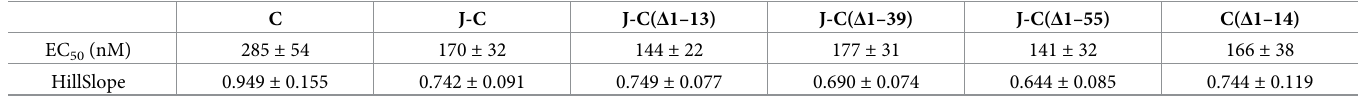
Table 3. EC 50 and Hill coefficient of RII β 2 C 2 , RII β 2 J-C 2 RII β 2 J-C( Δ 1–13) 2 , RII β 2 J-C( Δ 1–38) 2 , RII β 2 J-C( Δ 1–54) 2 , and RII β 2 C( Δ 1–14) 2 holoenzymes from cAMP activation